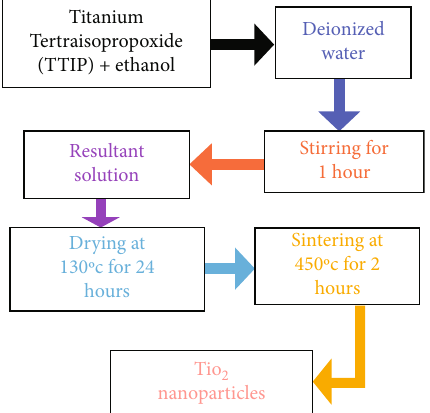
Figure 2: Preparation fl owchart of TiO